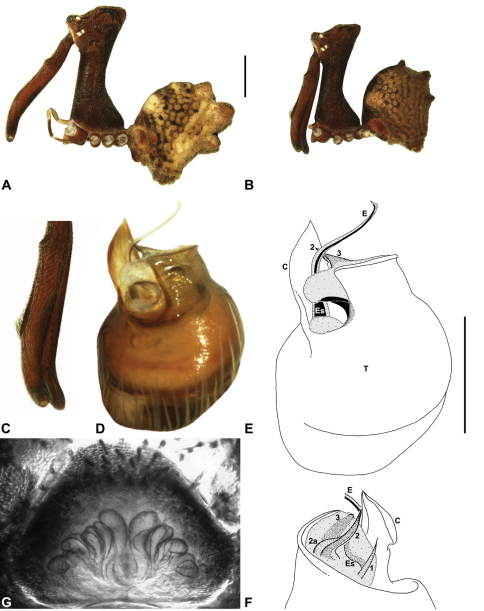
Austrarchaea dianneae sp. n. A–B, Cephalothorax and abdomen, lateral view: A, allotype female (QMB S90186) from Tamborine National Park, Queensland; B, holotype male (QMB S90185) from Tamborine National Park, Queensland. C, Holotype male chelicerae, lateral view, showing accessory setae. D–F, Holotype male pedipalp: D–E, bulb, retrolateral view; F, detail of distal tegular sclerites, prodistal view. G, Allotype female internal genitalia, dorsal view. C = conductor; E = embolus; Es = embolic sclerite; T = tegulum; (TS)1–3 = tegular sclerites 1–3. Scale bars: A–B = 1.0 mm; E = 0.2 mm.